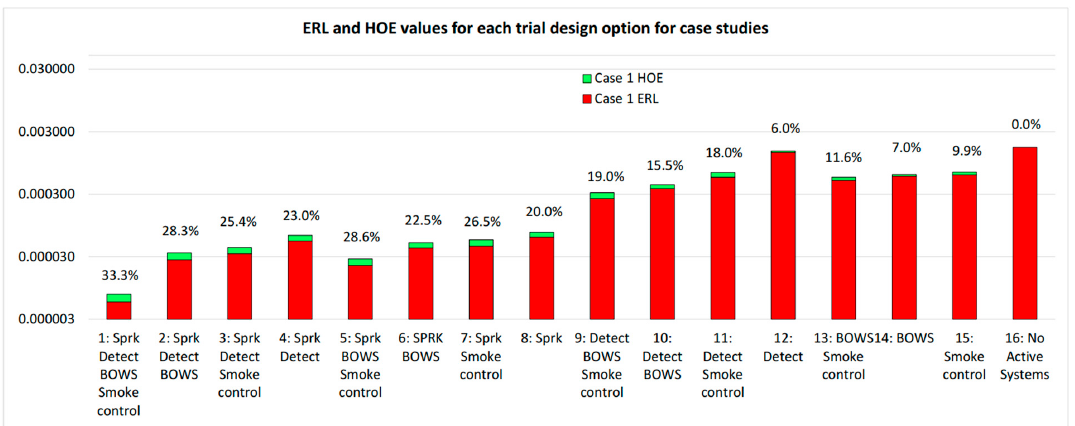
Figure 3. ERL and HOE impact on trial designs for Case #1 [log y-axis].